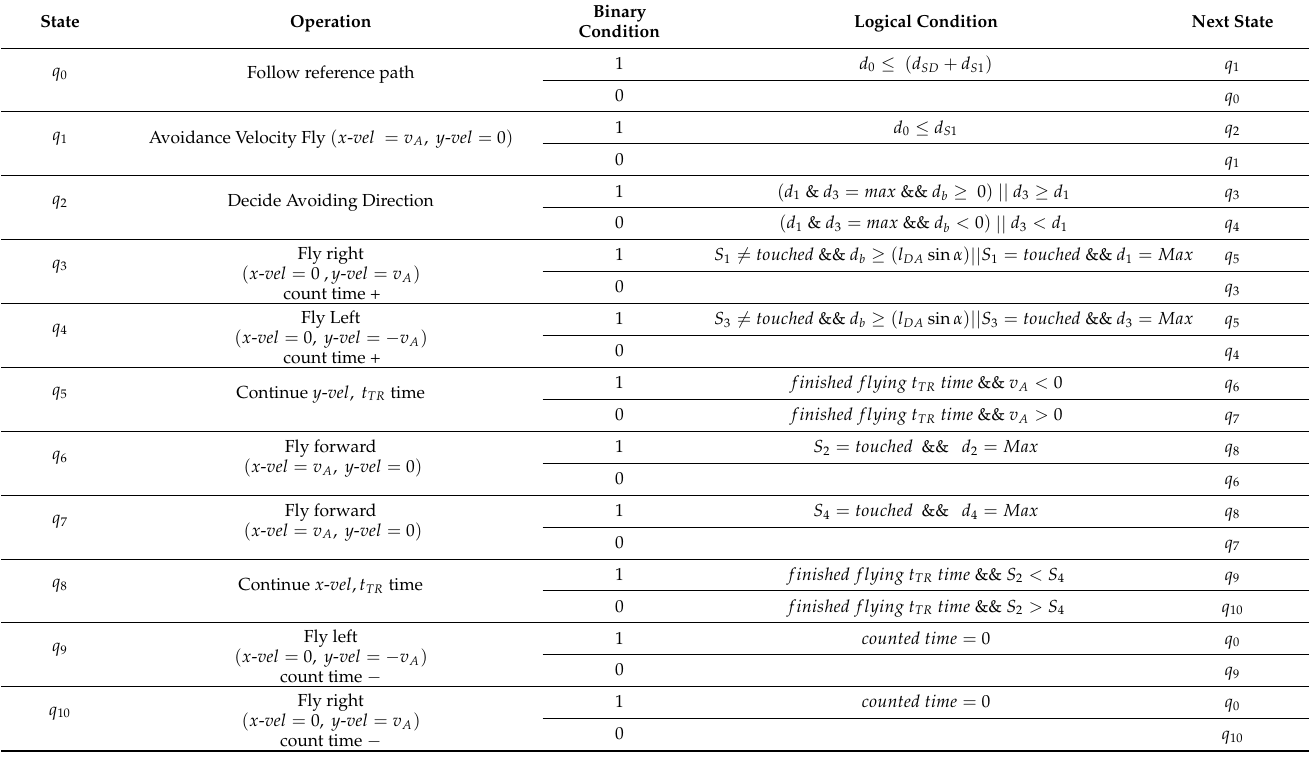
Table 1. State table of the